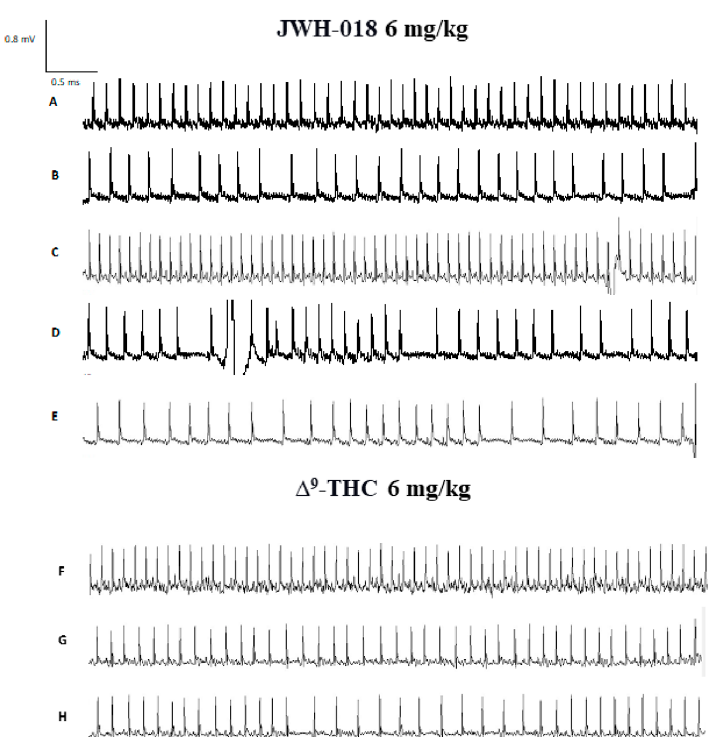
Figure 3. ECG track of mice treated with JWH-018 (6 mg/kg) ECG track representing basal (panel ( A )), bradycardia (panel ( B )), tachycardia (panel ( C )) and arrhythmias (panels ( D , E )). ECG track of mice treated with ∆ 9 -THC (6 mg/kg). ECG track representing basal (panel ( F )), bradycardia (panel ( G )), and arrhythmias (panel ( H )). Recording was performed with ecgTUNNEL system (Emka Technologies), and tracks was exported after analysis with iox2 software.